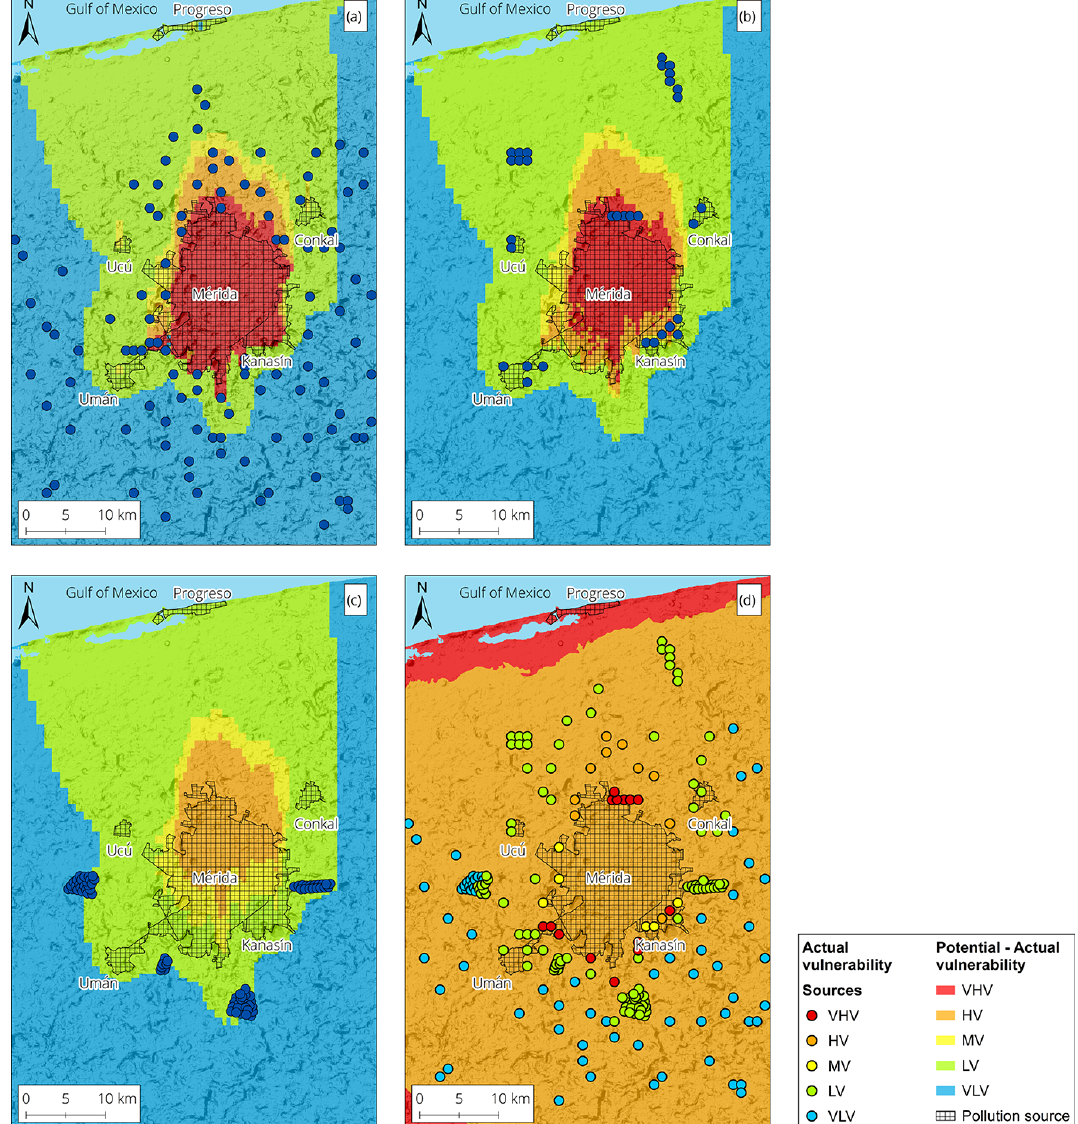
Figure 10. IKAV-A source vulnerability maps for a 60-year simulation (13th stress period). IKAV-A for the (a) lower epikarst, (b) preferen- tial, and (c) rest of the aquifer layers. (d) The combined IKAV-P (resource) and IKAV-A (source) for the